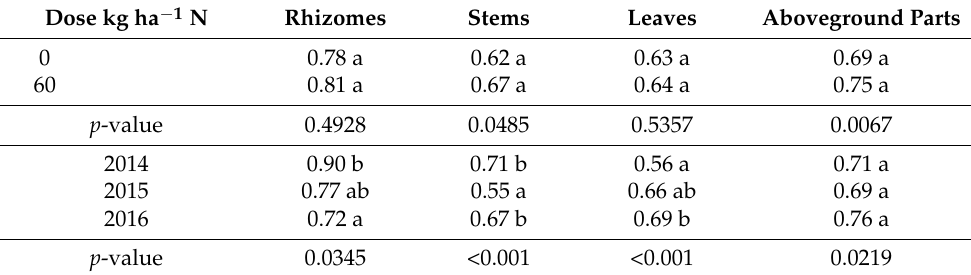
Table 7. Sulphur content in dry matter of miscanthus in g kg −1 (average for years 2014–2016).